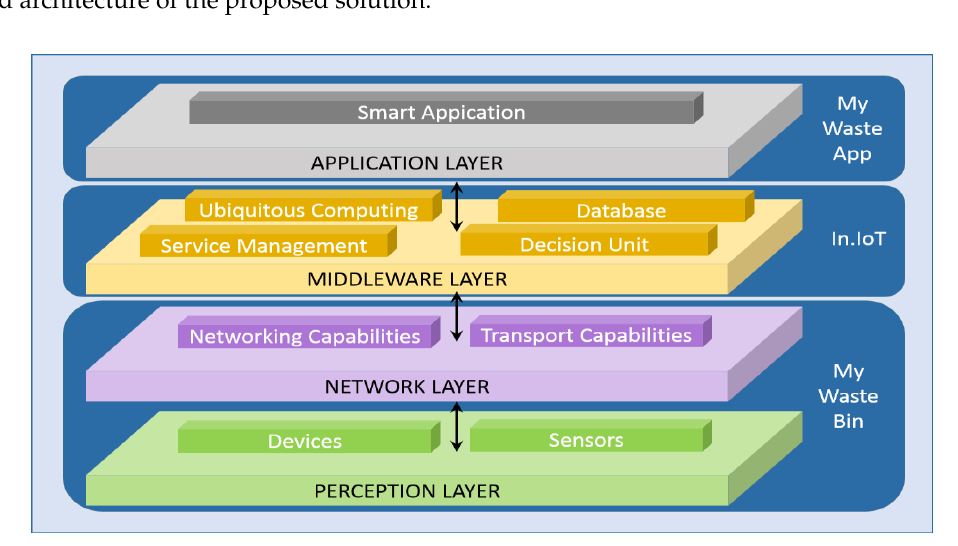
Figure 1. Layered architecture for the waste management system.